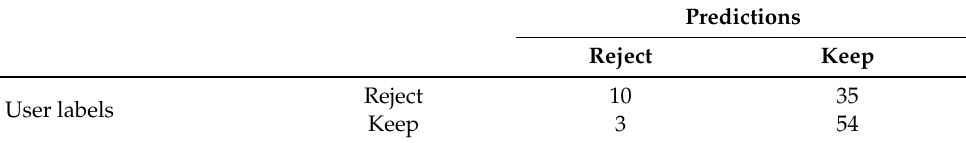
Table 6. Confusion matrix for the test